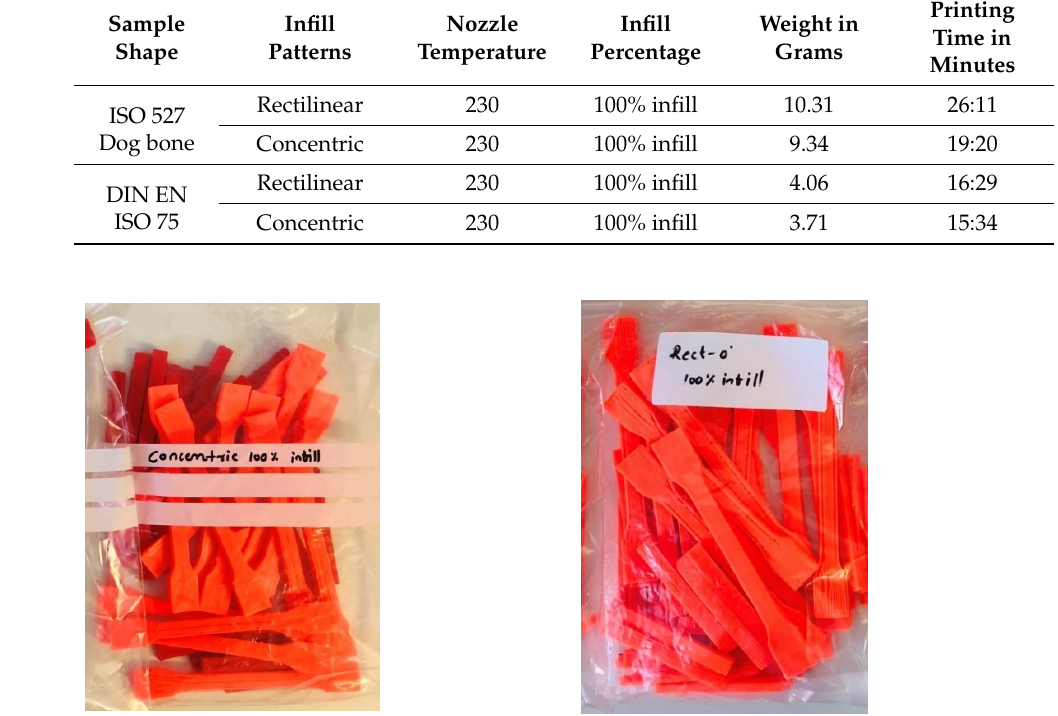
Figure 6. 3D-printed samples.